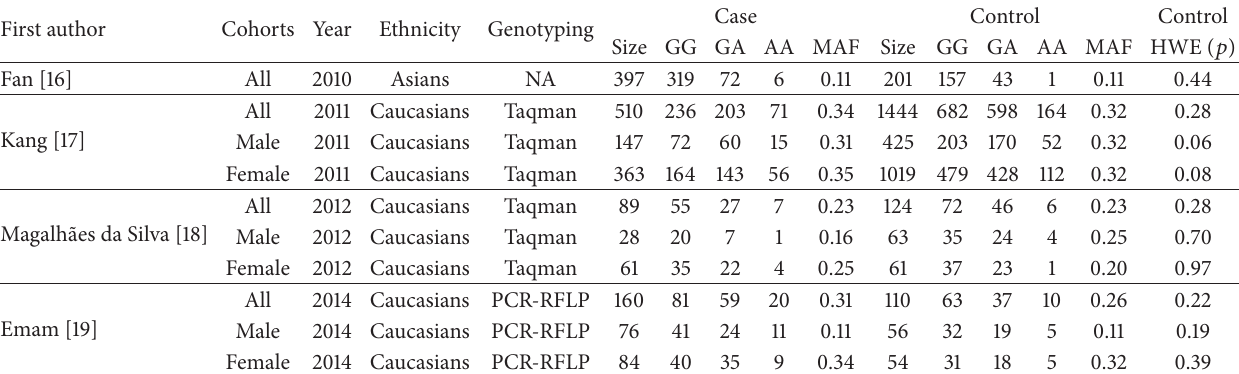
Table 1: Principle characteristics of the studies included in the meta-analysis for association between eNOS rs2070744 and POAG. First